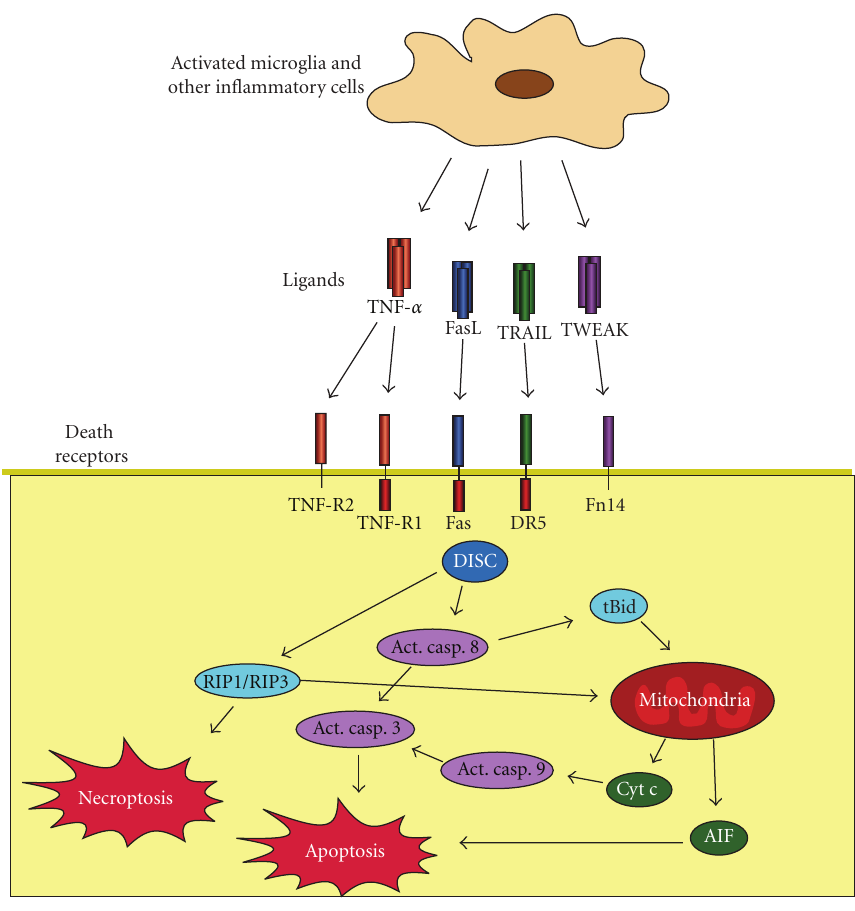
Figure 3: The extrinsic pathway of apoptosis. Inflammatory cells secrete death receptor ligands which bind to receptors on neurons, oligodendroglial and other receptor-expressing cells, recruiting the death-inducing signalling complex (DISC) and triggering both apoptotic and necroptotic